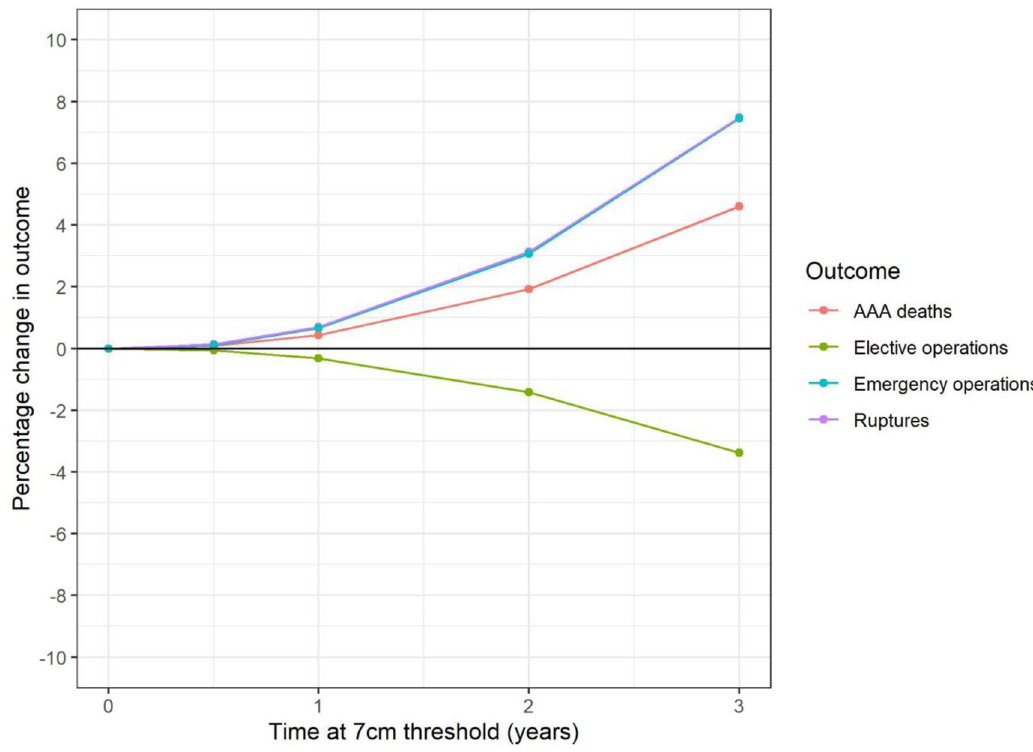
Fig 5. Surveillance cohort: Change in key outcomes over varying time at increased (7cm) threshold (model I3). Table 2 the corresponding numbers of events for AAA deaths and emergency operations. The